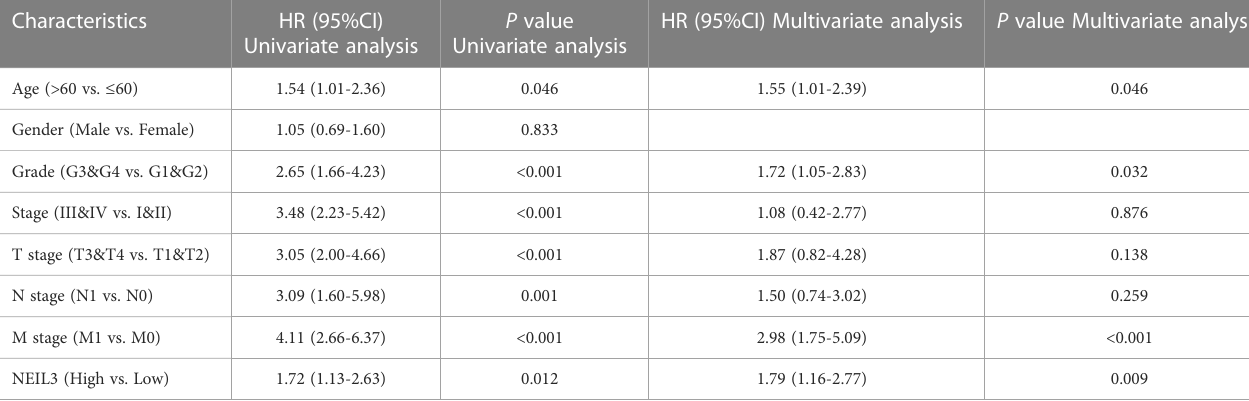
TABLE 2 Univariate analysis and multivariate analysis of the prognostic factors in KIRC patients.